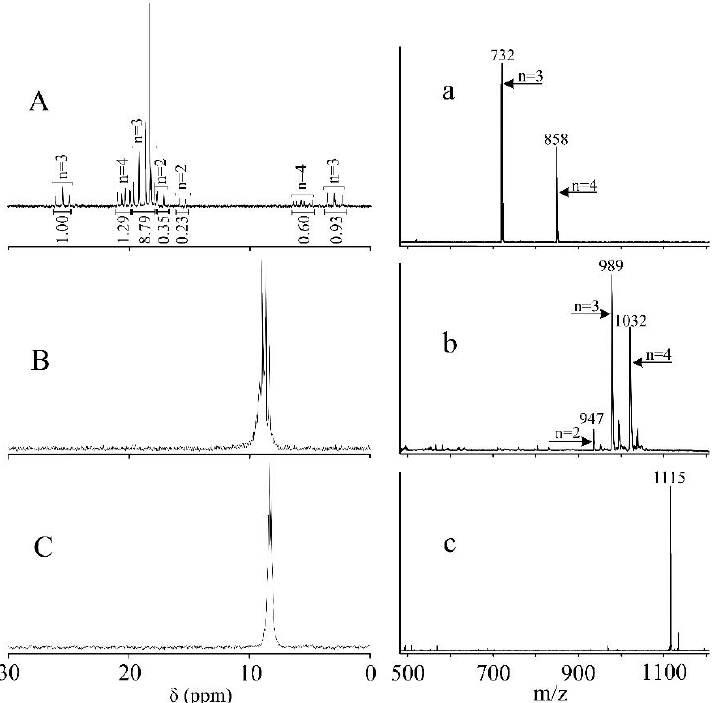
Figure2. 31 PNMR( A , B and C )andMALDI-TOF( a , b and c )spectraofproductsI,IIand Figure 2. 31 P NMR ( A , B and С ) and MALDI-TOF ( a , b and c ) spectra of products I, II and III, respectively.